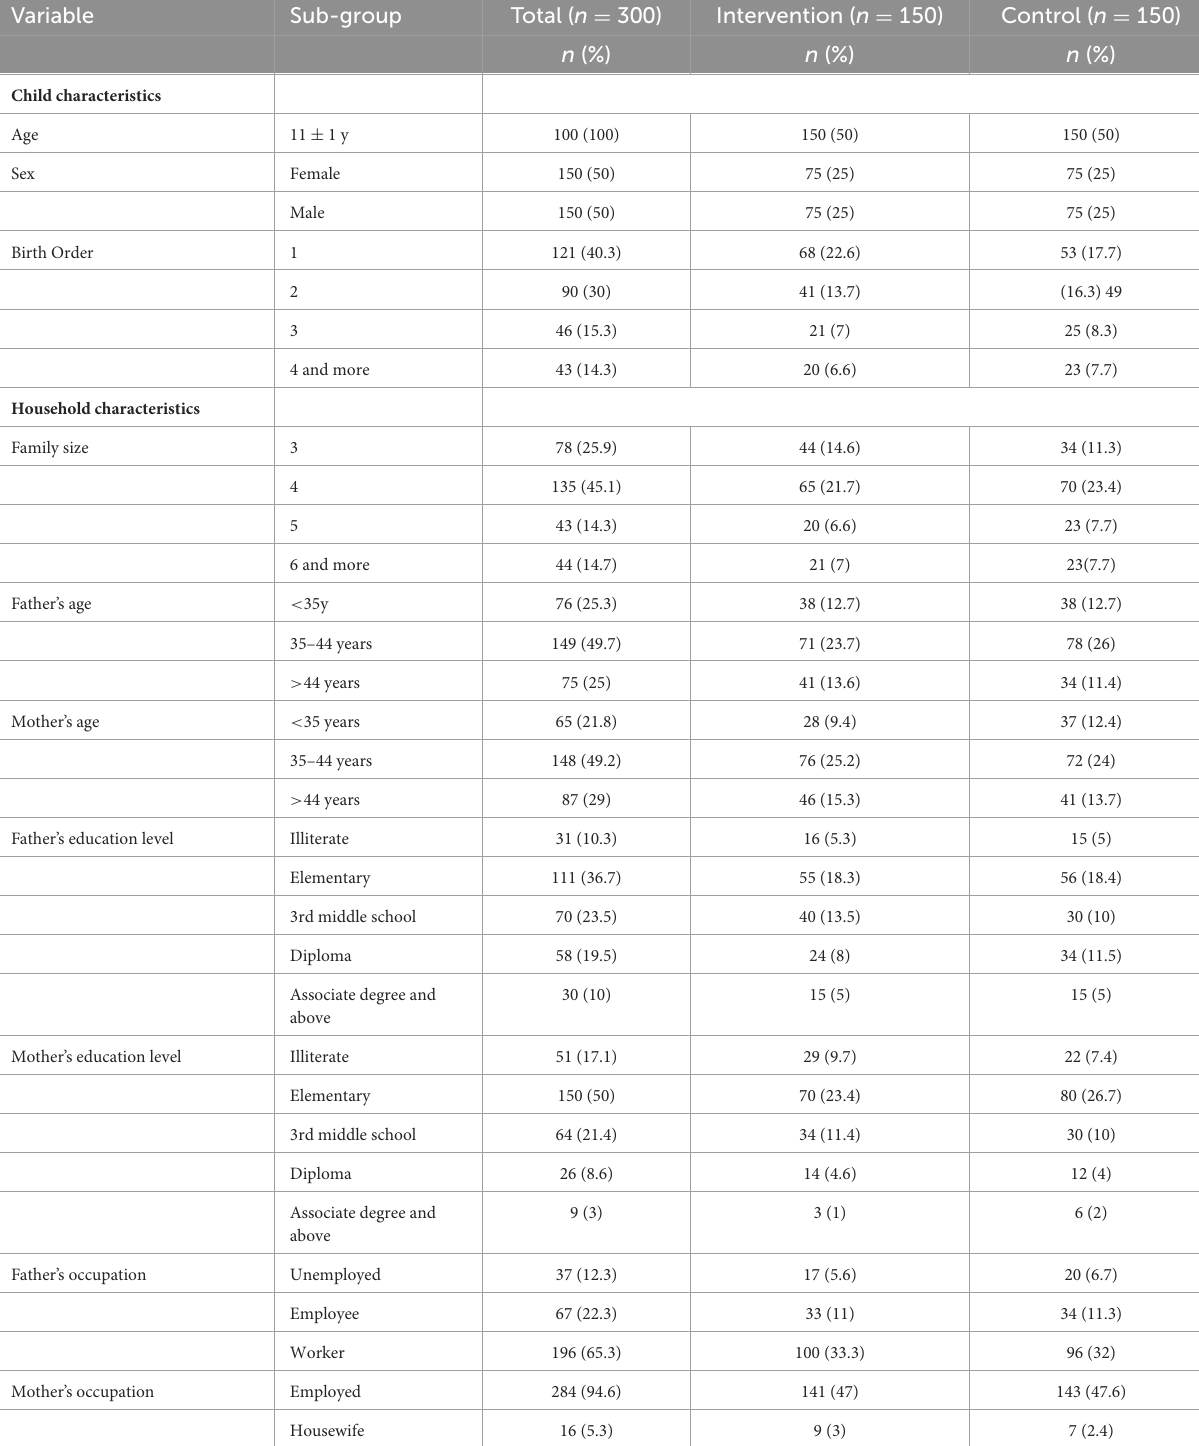
TABLE 3 Demographic and social characteristics of student participants ( n =